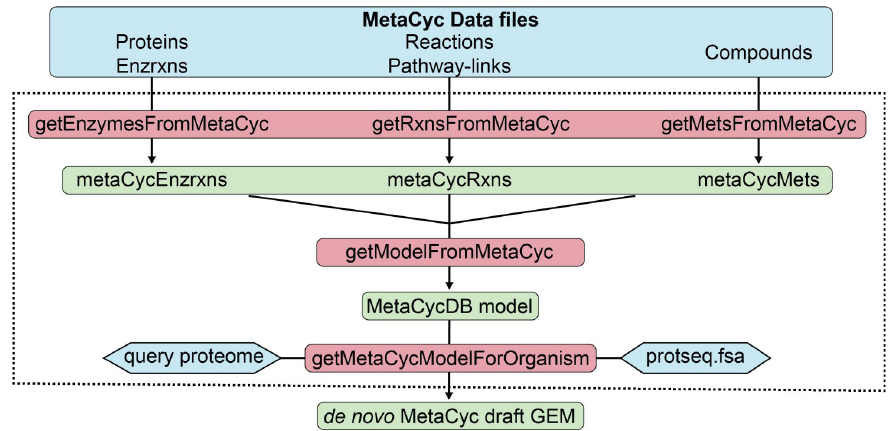
Fig 7. Flow-chart of the functions for MetaCyc-based de novo GEM reconstruction in RAVEN 2.0. The MetaCyc- based module (indicated by the dashed line) reads in data files of MetaCyc pathways, reactions, compounds and enzymes, and converts the information into a model structure, which can then be utilized for automatic draft GEM generation through querying the protein sequences in MetaCyc (protseq.fsa). Different components are color coded as MetaCyc data files in blue, MATLAB functions in red, and data structures in